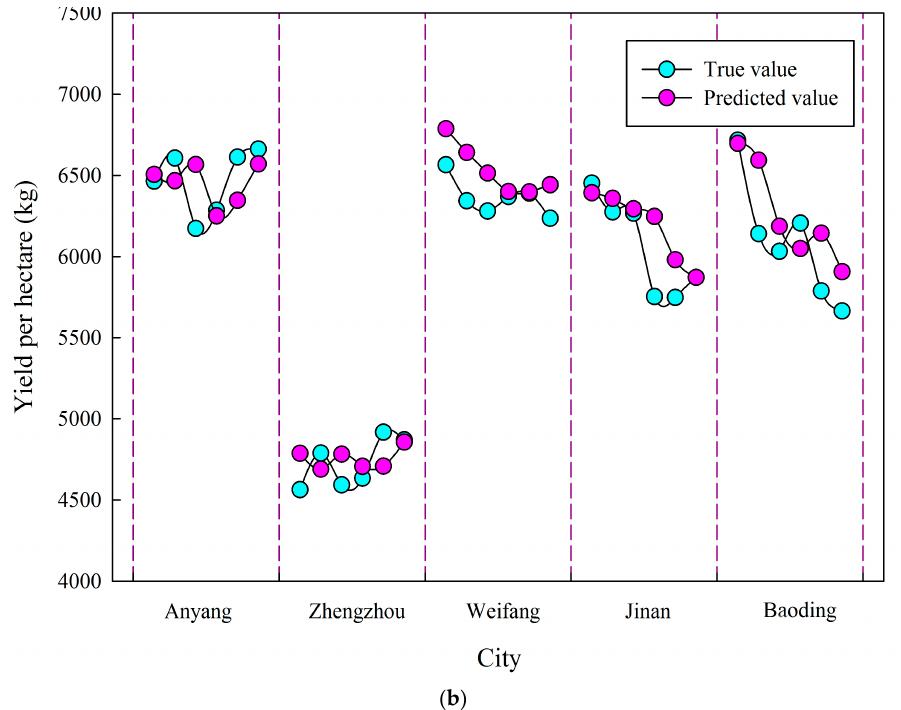
Figure 5. The comparison of predicted value and true value of validation set in the model. ( a ) Winter wheat and ( b ) summer corn.